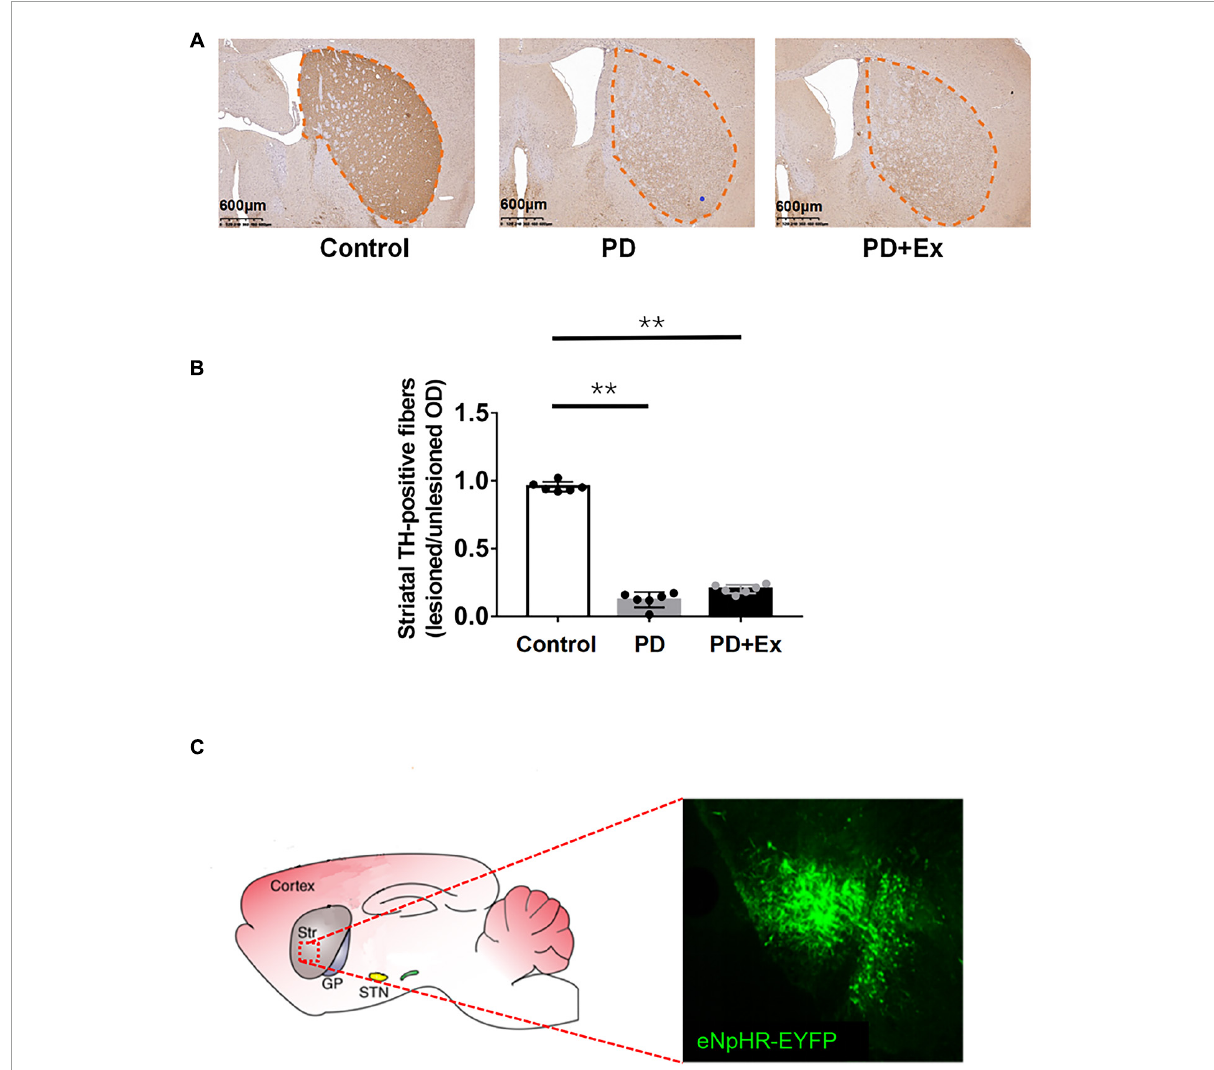
FIGURE3 Striatal tyrosine hydroxylase (TH) positive fiber expression. (A) Schematic diagram of TH staining of mice in deach group (black outline, scale bar = 1.25 mm); (B) the ratio of TH positive fiber expression; (C) eNpHR-EYFP expression in Str. Micrographs of a brain slice in confocal scanning (one-way ANOVA, p < 0.05); all data are showed as mean ± SEM. ** p < 0.01.